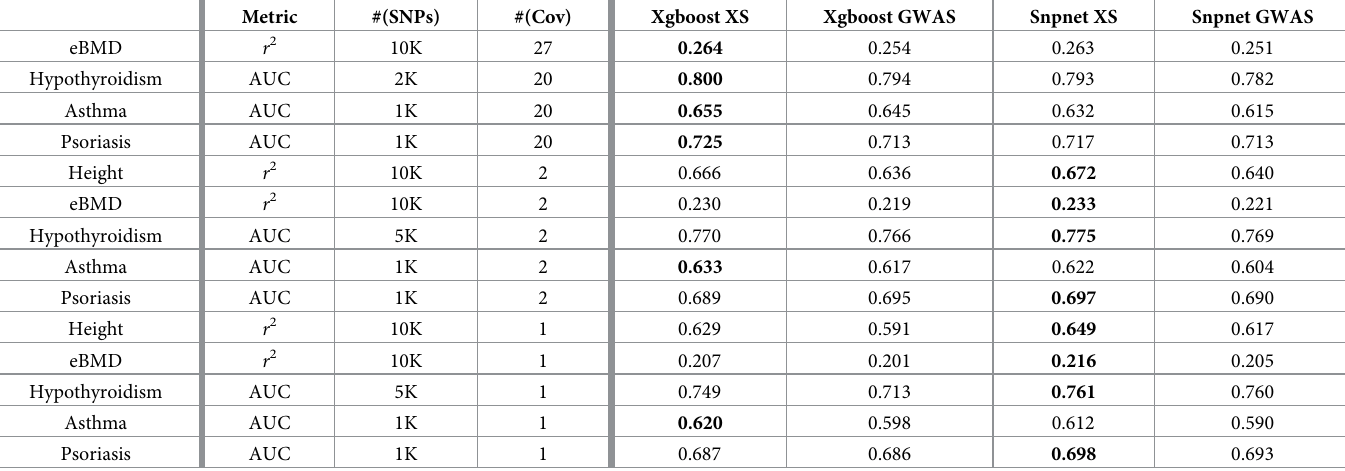
Table 2. Comparison of GWAS- and XGBoost-based (denoted XS) SNP selections.